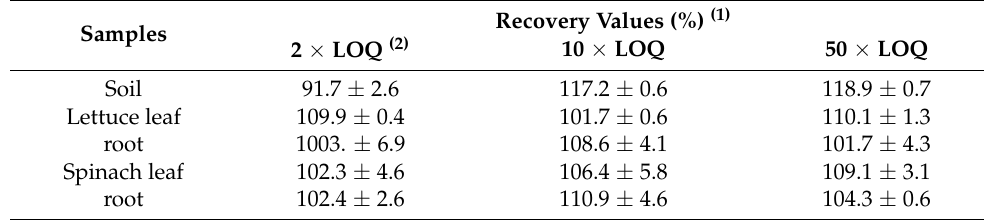
Table 2. Recovery values of imicyafos fortified in the soil and plant samples.